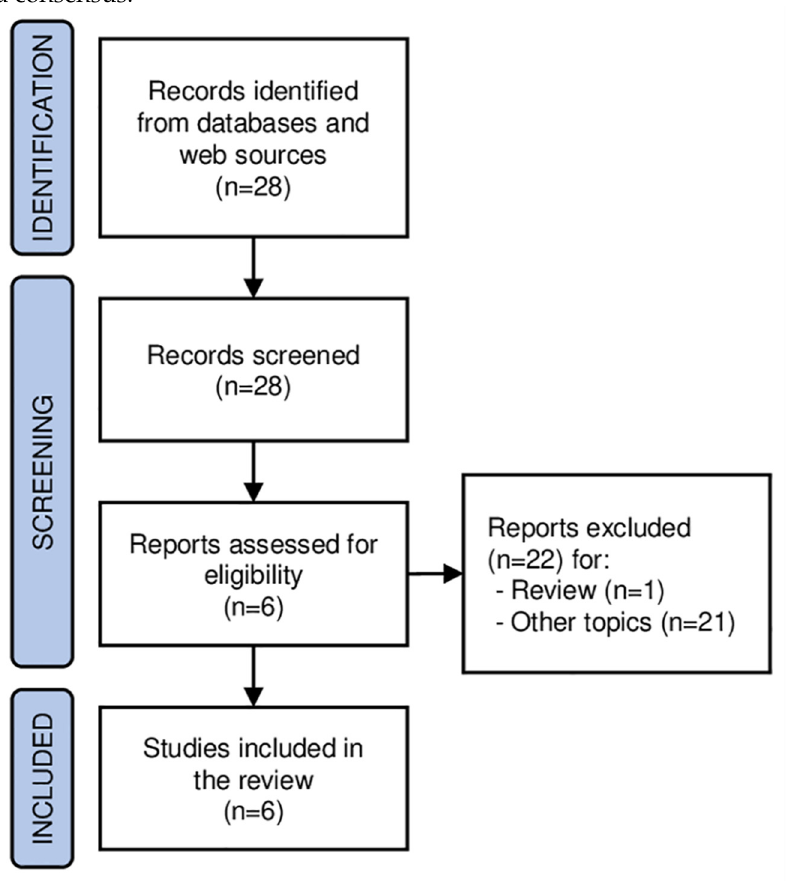
Figure 1. PRISMA statement.